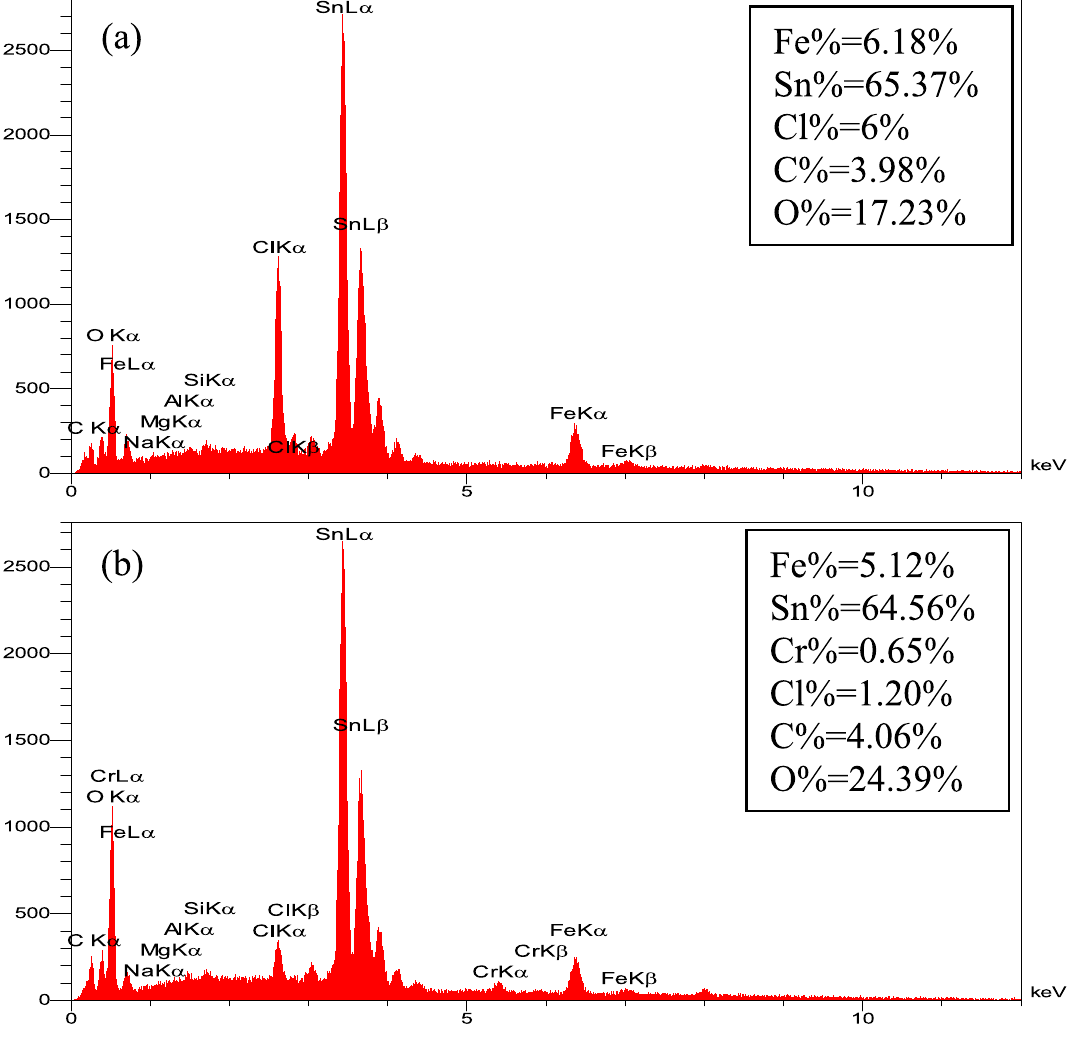
Figure 3. EDS spectra of ( a ) Talc-nZVI/6Sn and ( b ) Talc-nZVI/6Sn after reaction with Cr(VI).